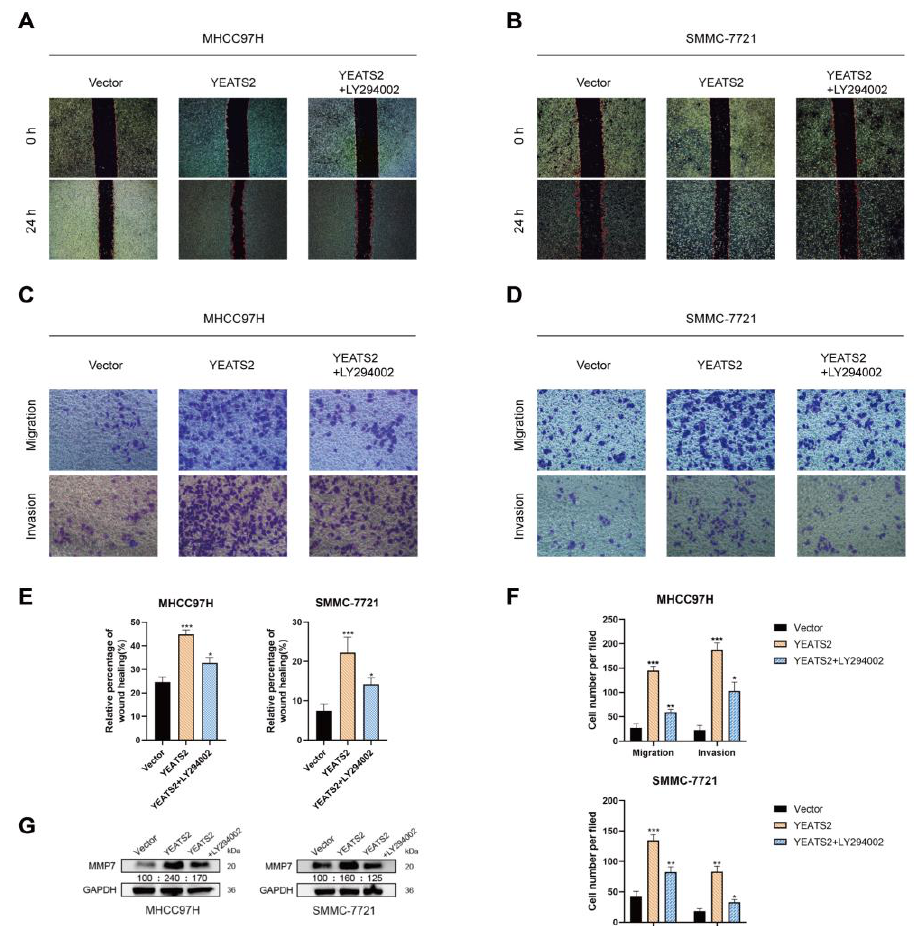
Figure 6. YEATS2 affects the migration and invasion of liver cancer cells through the PI3K/AKT/MMP7 pathway. ( A , B , E ) The PI3K inhibitor LY294002 partially reversed the effect of YEATS2 overexpression on cell migration in wound healing assays. ( C , D , F ) In the Transwell experiments, the PI3K inhibitor LY294002 partially restored the effect of YEATS2 overexpression on cell migration and invasion. ( G ) Western blot analysis of MMP7 expression after using LY294002. Data are expressed as the mean ± SD. * p < 0.05, ** p < 0.01, *** p < 0.001.